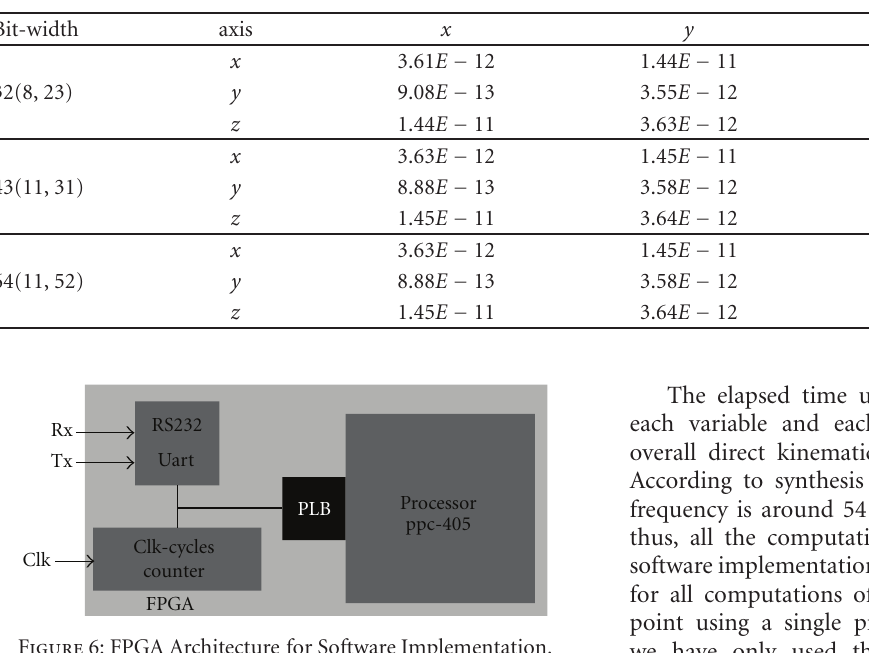
Table 6: MSE for di ff erent bit-width representation.